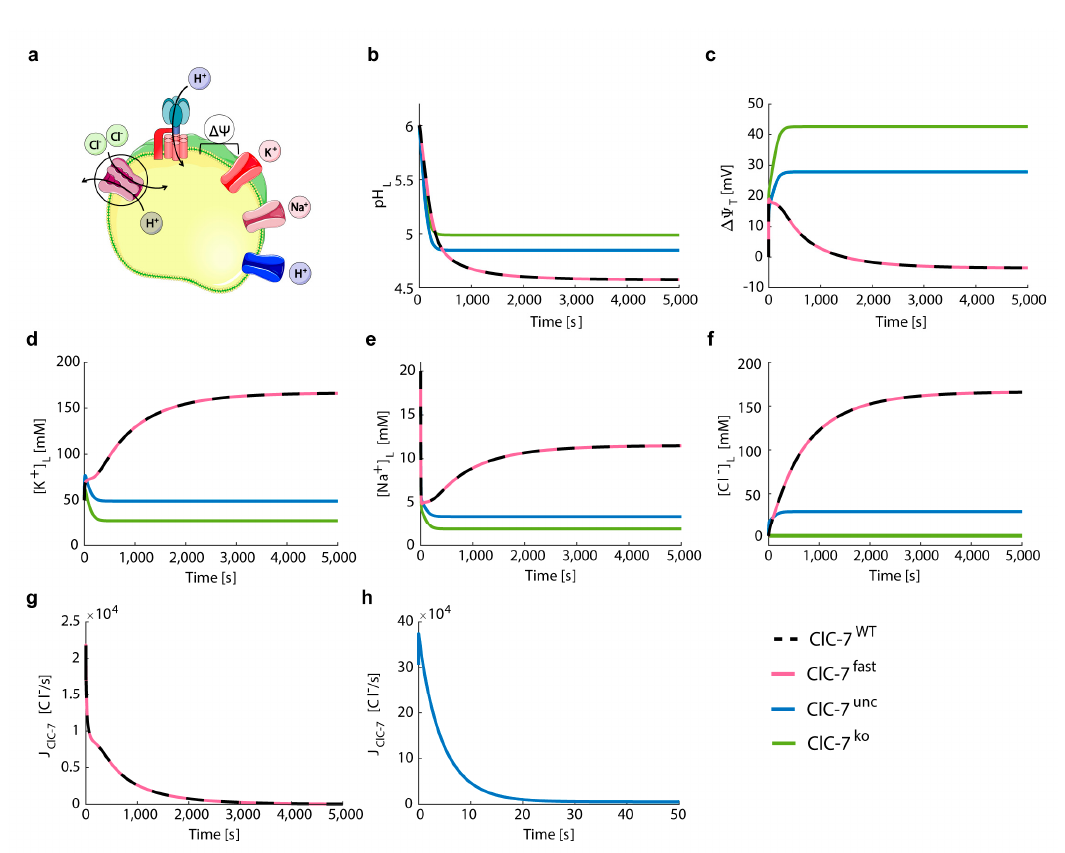
Figure 3. Differences in ClC-7 kinetics do not affect lysosomal acidification. ( a ) Schematic representation of the model with ClC-7 antiporters, V-ATPases, potassium and sodium channels, and proton leak. The cartoon was created using Servier Medical Art templates (https://smart.servier.com), licensed under a Creative Commons License (https://creativecommons.org/licenses/by/3.0/). ( b – h ) Depicted for the different ClC-7 scenarios during lysosomal acidification (ClC-7 WT , dashed black line; ClC-7 fast , red; ClC-7 unc , blue; ClC-7 ko , green) are ( b ) luminal pH, ( c ) total membrane potential, ( d ) luminal concentrations of potassium, ( e ) sodium, and ( f ) chloride ions, as well as the turnover rates of ( g ) ClC-7 WT and ClC-7 fast , and ( h ) ClC-7 unc . Initial conditions provided in Table S1.